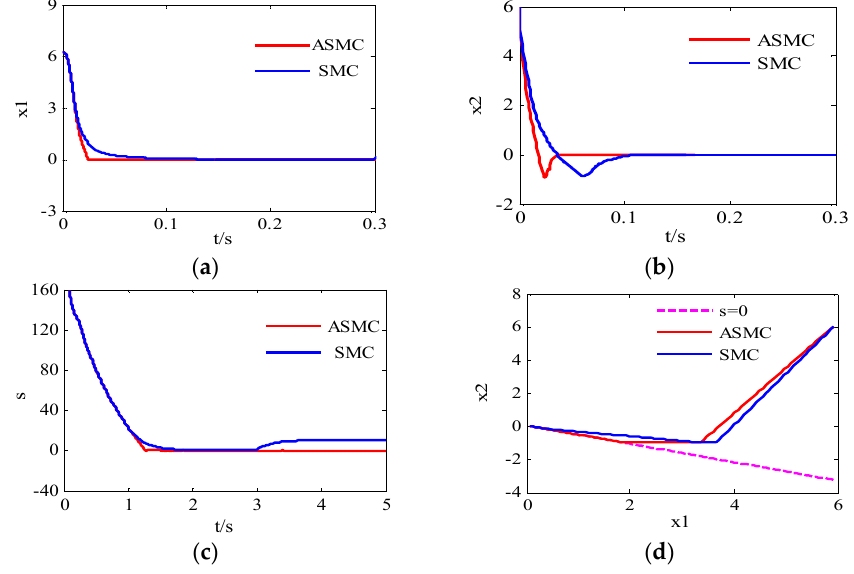
Figure 1. The performance contrast of adaptive variable-rated sliding mode controller (ASMC) and sliding mode controller (SMC): ( a ) the response of 1 x ; ( b ) the response of 2 x ; ( c ) the time of approach process; and ( d ) the phase track of system.